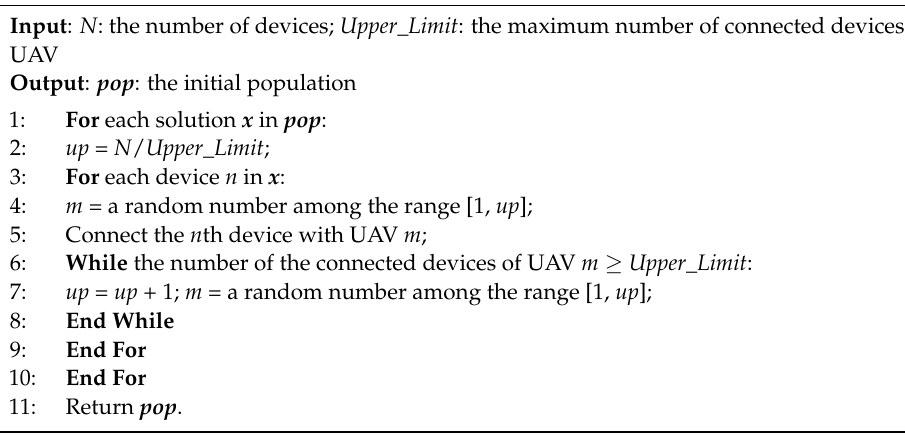
Algorithm 2: Pseudo-random initialization